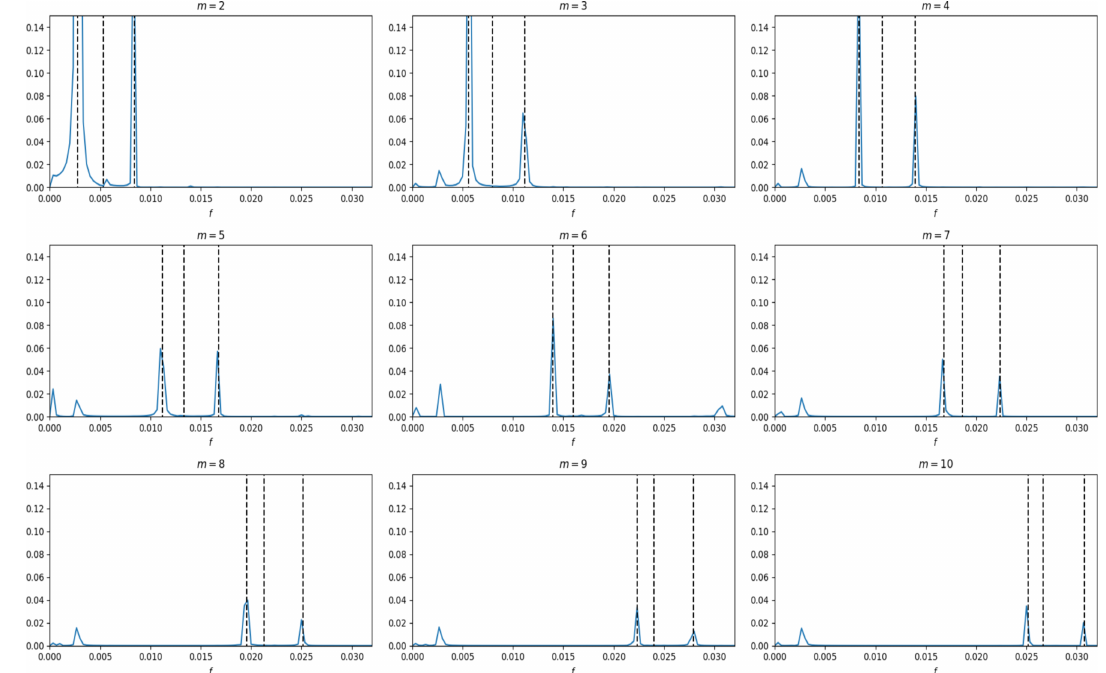
Figure 21 . A comparison of the dominant frequency components to the predicted frequencies of oscillation for modes 2 to 10 , all excited with (cid:15) = 0 . 1 , in parameter set B. They show a very good level of agreement for the higher and lower frequencies, with the intermediate frequency not appearing because it is very close to a purely longitudinal oscillation for vortons near the chiral